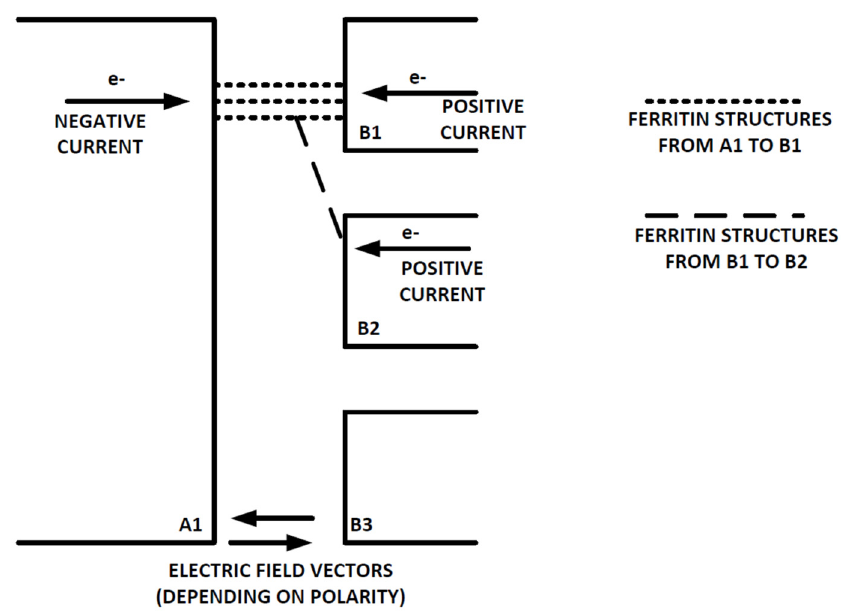
Figure 10. Electron Transport Structures.